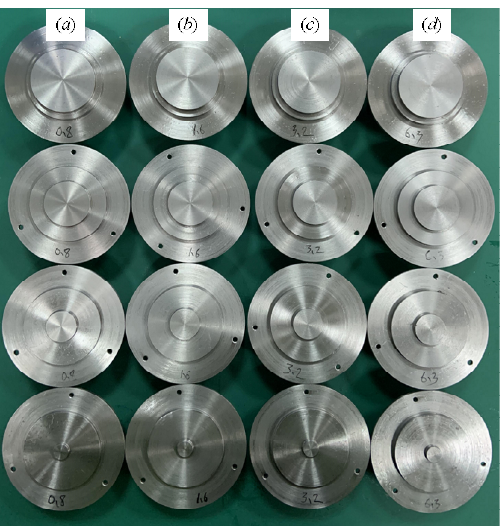
Figure 6. Surface to be tested: ( a ) Sa 1.6 μm; ( b ) Sa 3.2 μm; ( c ) Sa 4.5 μm; ( d ) Sa 5.8 μm.